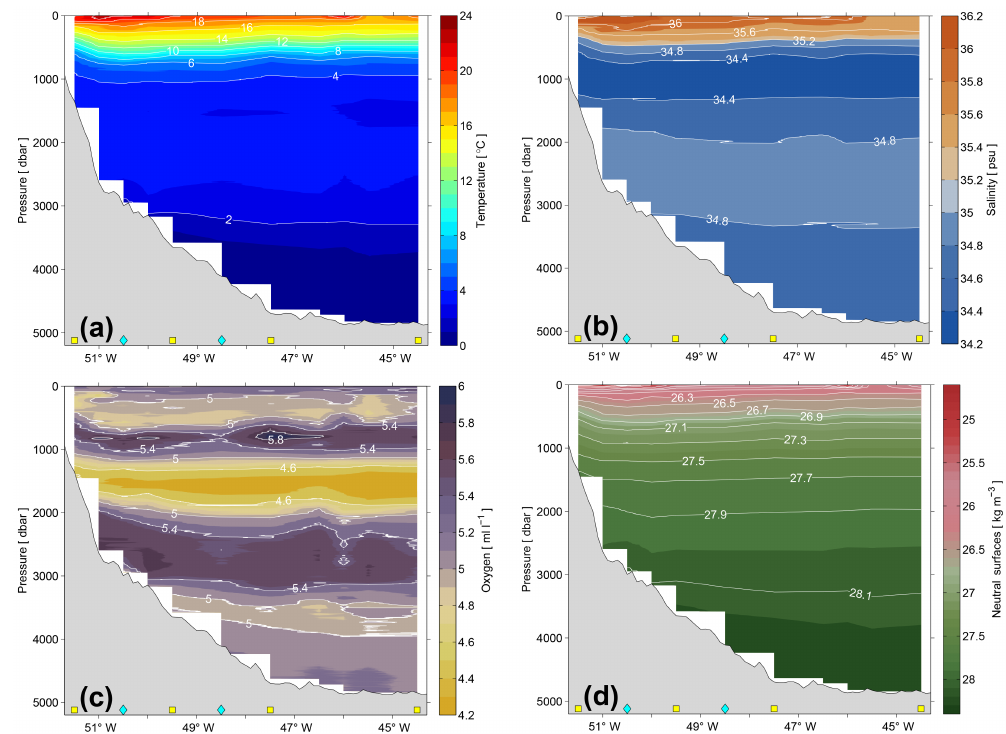
Figure 3. Average sections of in situ temperature (a) , salinity (b) , dissolved oxygen (c) , and neutral density (d) . Sections from July 2010, December 2010, July 2011, and December 2012 are averaged in a simple manner to make these plots, solely to illustrate the approximate vertical distribution of the water masses in the